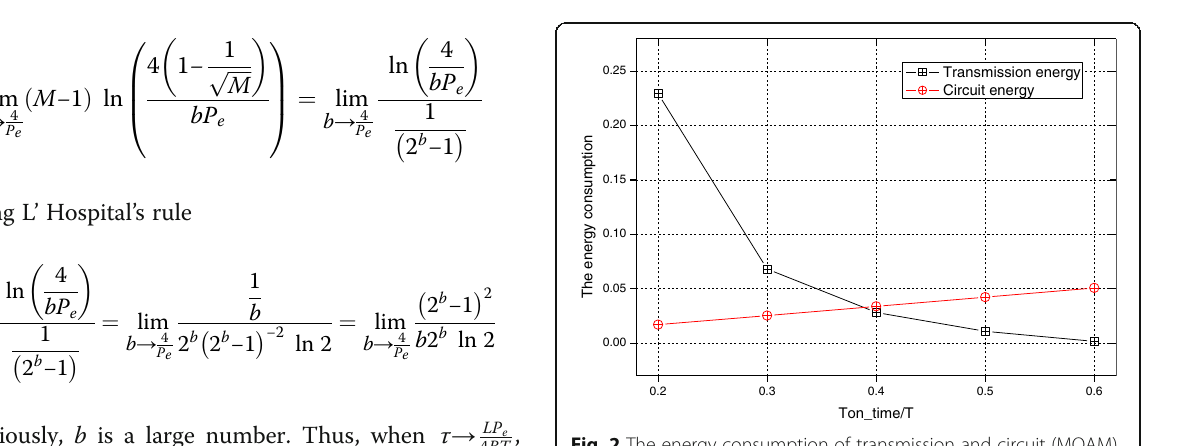
Fig. 2 The energy consumption of transmission and circuit